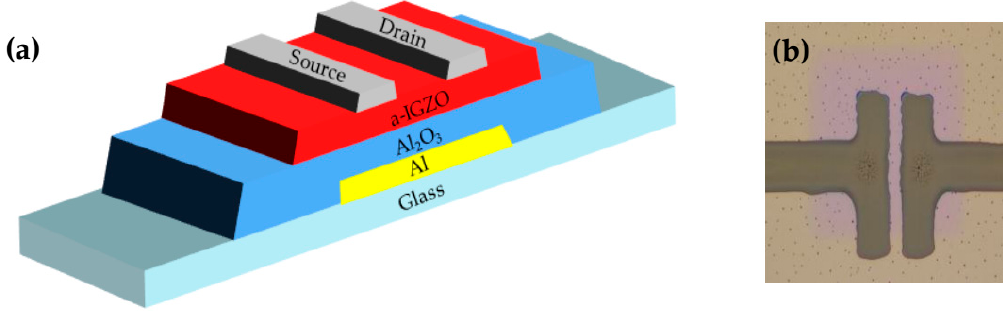
Figure 1. ( a ) Structure of printed S/D electrodes TFT; ( b ) the final device we have fabricated.